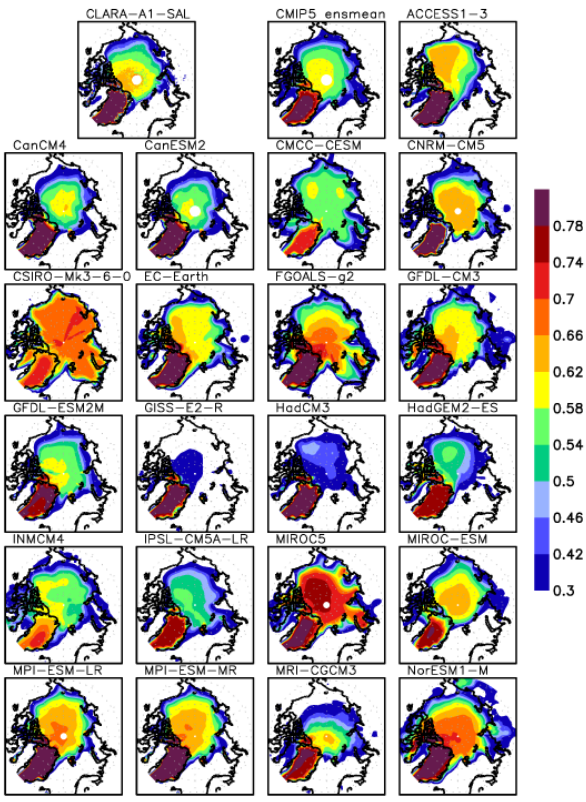
Fig. 4. Summer-averaged (JJA) surface albedo in CLARA-SAL, the CMIP5 ensemble mean and the individual CMIP5 models. Shown is the time average over the period